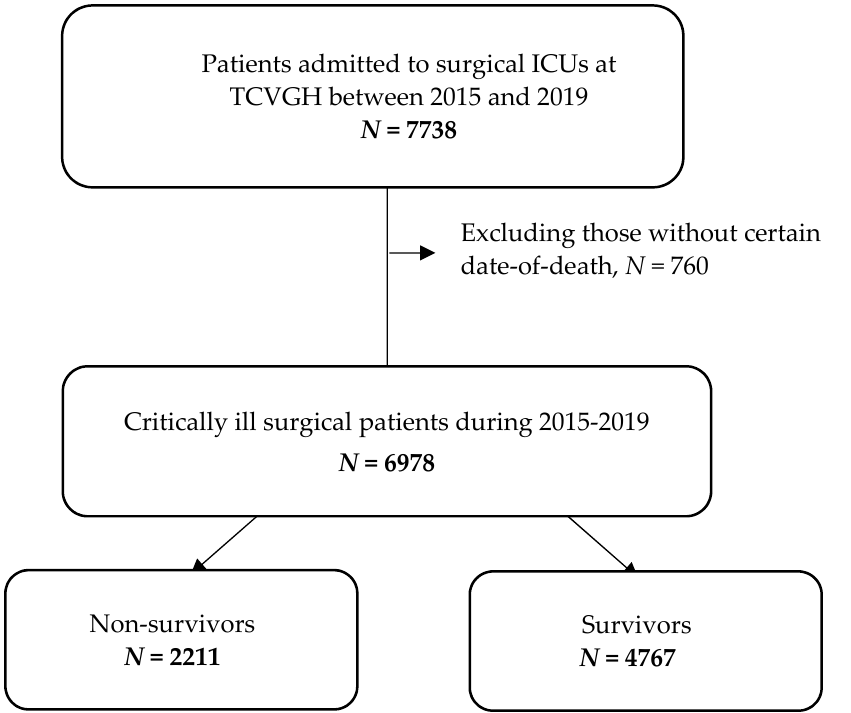
Figure 1. Flow diagram of the enrollment of subjects eligible for analyses.